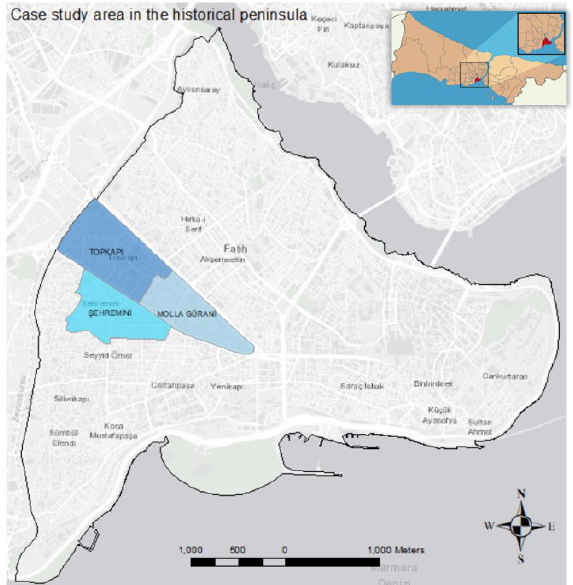
Figure 1 . Case study area in Fatih, Istanbul. Sources: de Vries, 2022, and https://en.wikipedia.org/wiki/Fatih (Istanbul overview map top right